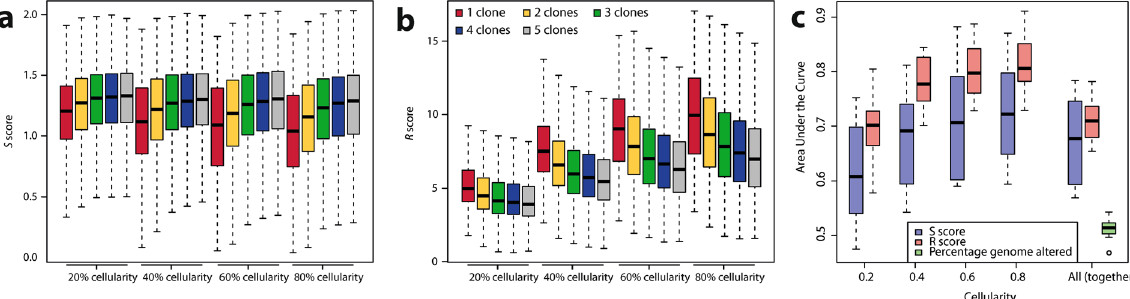
Figure 3. Accuracy of the S score in polyclonality detection in-silico . ( a , b ) Distribution of S and R scores per different levels of cellularity (tumour cell fraction in a sample), according to the number of clones present in in-silico clonal mixtures. ( c ) Distribution of the Area Under the Curve in all 16 sets for both S and R scores at different cellularity levels. “All” indicates that samples with 0.2, 0.4, 0.6 and 0.8 cellularity were all included in the dataset. The percentage of genome altered was calculated